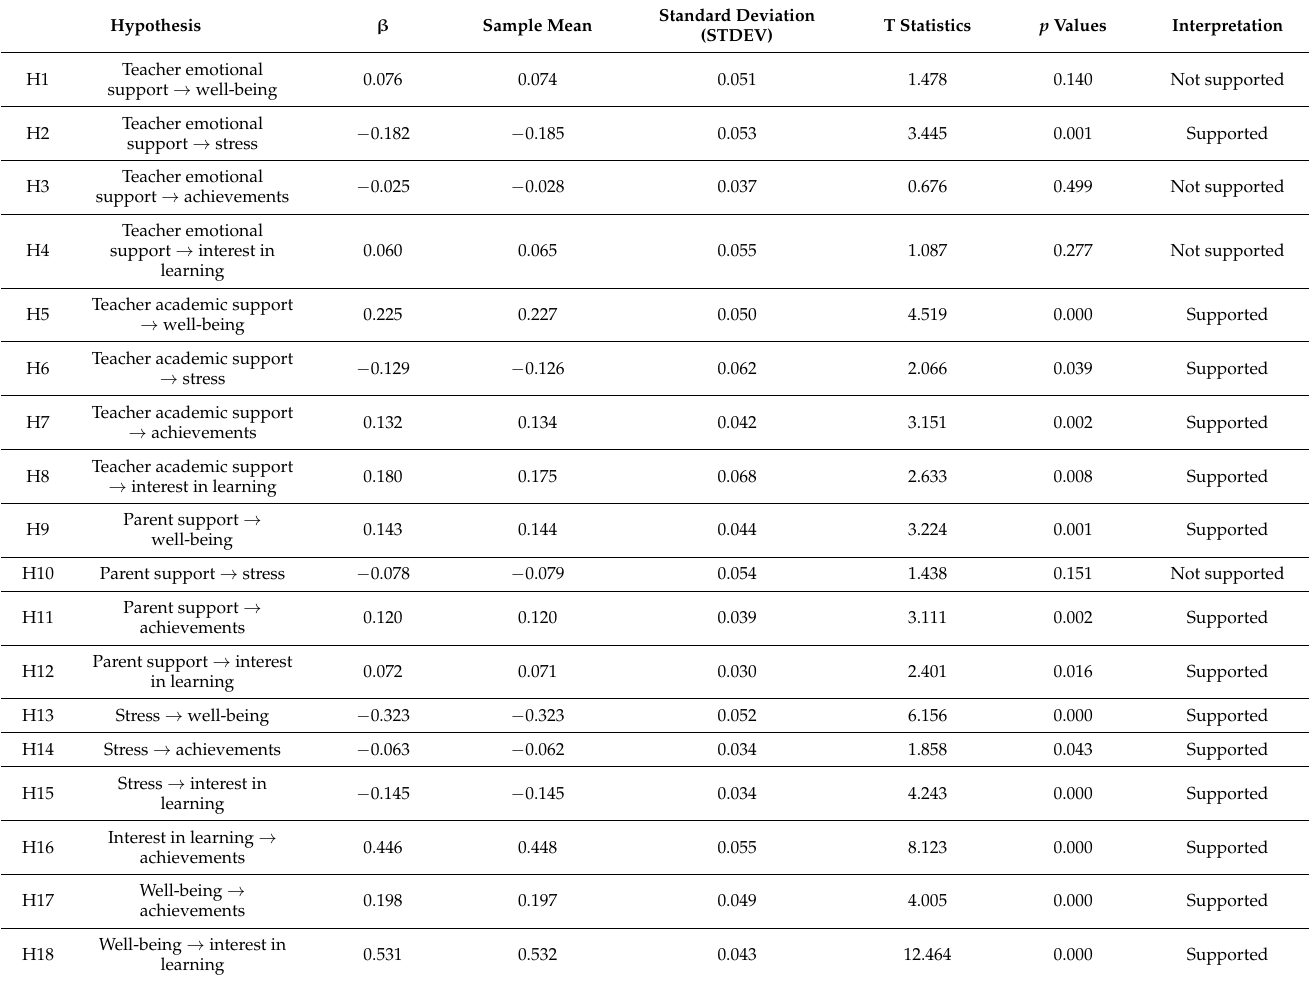
Table 8. The final results of hypotheses testing, the value of T statistics, and the p value.